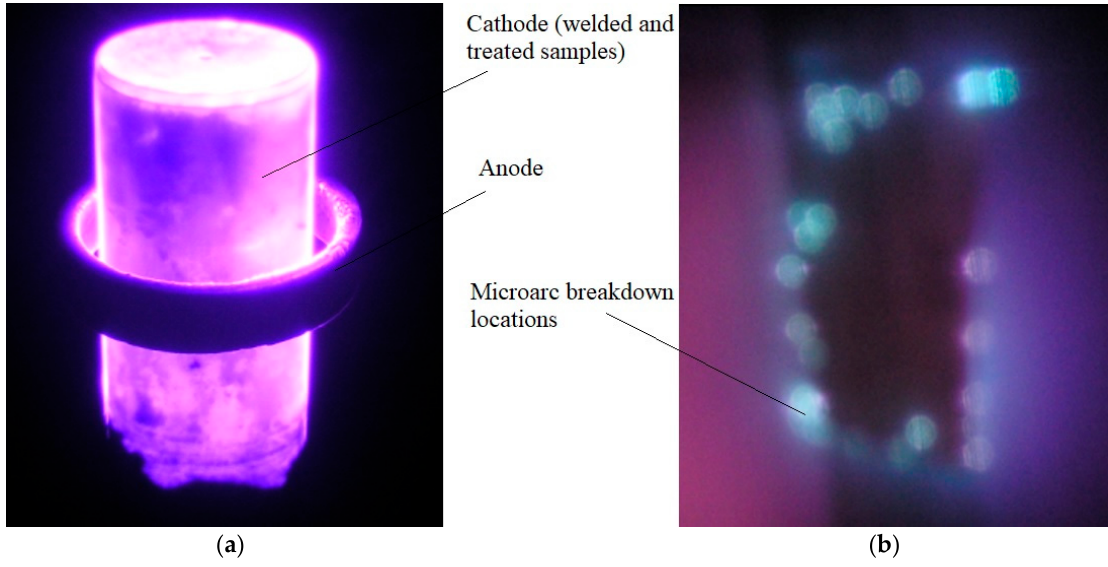
Figure 8. The visualized scheme of treatment in a stable ( a ) and disturbed ( b ) by a multiple micro-arcs breakdown glow discharge.